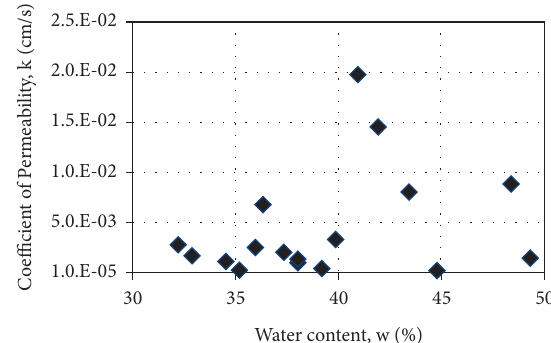
Figure 6: Relationship between clay/sand ratio and coefficient of permeability and water content.